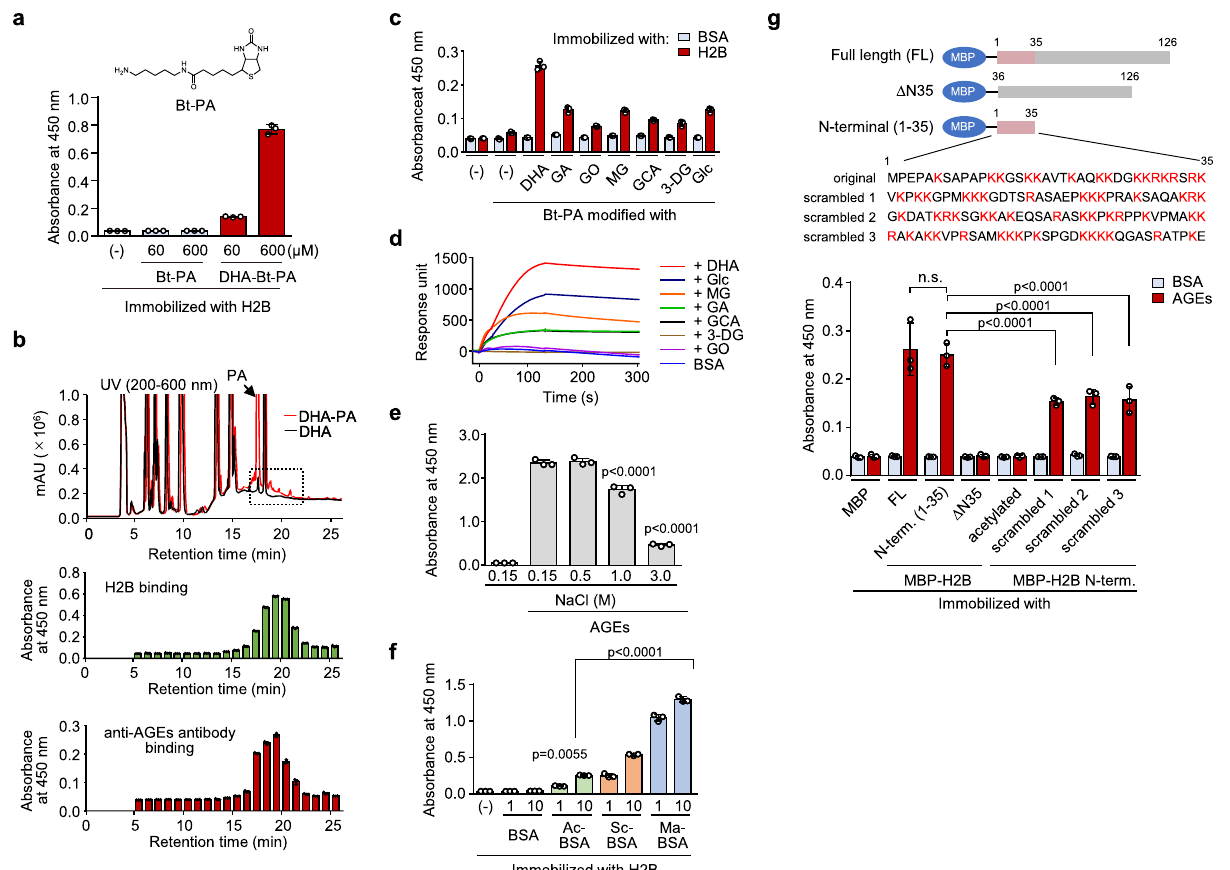
Fig. 2 Ubiquitous recognition of AGEs by histones. a Binding of DHA-modi fi ed Bt-PA to histone H2B. Recombinant histone H2B immobilized on ELISA plate was incubated with either Bt-PA or DHA-Bt-PA. The binding was detected using streptavidin-HRP. Data are mean ± S.D. of triplicate samples (representative of three independent experiments). b HPLC analysis of DHA-modi fi ed Bt-PA capable of binding to H2B. The reaction mixture of Bt-PA and DHA was separated by reverse-phase HPLC, and each fraction was measured for the binding to H2B (middle ) and anti-AGEs antibodies (bottom). The reactions were monitored with absorbance at 200 – 600 nm (top). The dashed square indicates the region with the binding activity to H2B and anti-AGEs antibody. Data are mean ± S.D. of triplicate samples (representative of three independent experiments). c Binding of modi fi ed Bt-PAs to histone H2B. Bt-PA was incubated with DHA, glucose (Glc), and glucose metabolites, such as glycolaldehyde (GA), glyoxal (GO), methylglyoxal (MG), glyceraldehyde (GCA), and 3-deoxyglucosone (3-DG), and the binding to histone H2B was evaluated by solid-phase binding assay. Data are mean ± S.D. of triplicate samples (representative of three independent experiments). d Surface plasmon resonance measurements. The interaction of H2B and either BSA or AGEs (10 µ g/ ml) was monitored. e Effect of NaCl on binding of AGEs to H2B. H2B immobilized on ELISA plate was incubated with Bt-AGEs (5 μ g/ml) under the indicated concentrations of NaCl. Data are mean ± S.D. of triplicate samples (representative of three independent experiments). Dunnett ’ s test (two- sided), relative to AGEs treatment under 0.15 M NaCl. f Binding of acylated proteins to the recombinant histone H2B. Data are mean ± S.D. of triplicate samples (representative of three independent experiments). Dunnett ’ s test (two-sided), relative to the no-treatment control. g Involvement of H2B N - terminal tail region and its electrostatic property in the binding to AGEs. MBP-fusion H2B full length (FL), N -terminal (N-term. (1-35)), N -terminal deletion mutant ( Δ N35), acetylated Nterm. (1-35), or N -terminal scrambled fragments (scrambled 1, 2, and 3) were subjected to the solid phase binding assay. Data are mean ± S.D. of triplicate samples (representative of three independent experiments). Tukey – Kramer tests (two-sided), n.s. not signi fi cant ( p > AGEs to cells. To determine the presence of AGE-binding cells, thioglycolate (TG)-induced peritoneal cells were treated with either Bt-BSA or Bt-AGEs and analyzed by fl ow cytometry using streptavidin-APC. Figure 3a (left panel) and Supplementary Fig. S7 show the presence of APC positive (APC ( + )) cells in the Bt- AGEs-treated cells but not in the Bt-BSA-treated cells. APC positive cells were further gated on the population with APC positive pro fi les of the expression of both CD11b and F4/80, indicating that the cells involved in binding to AGEs in peritoneal cells were mainly macrophages (Fig. 3a right panel). Further examination of the cell-type speci fi city for the binding of AGEs revealed that signi fi cant binding of AGEs was observed only in macrophages and monocytes, not in dendritic cells, neutrophils, and eosinophils (Fig. 3b and Supplementary Fig. S8). The cellular binding of AGEs was also observed in macrophage cell lines, such